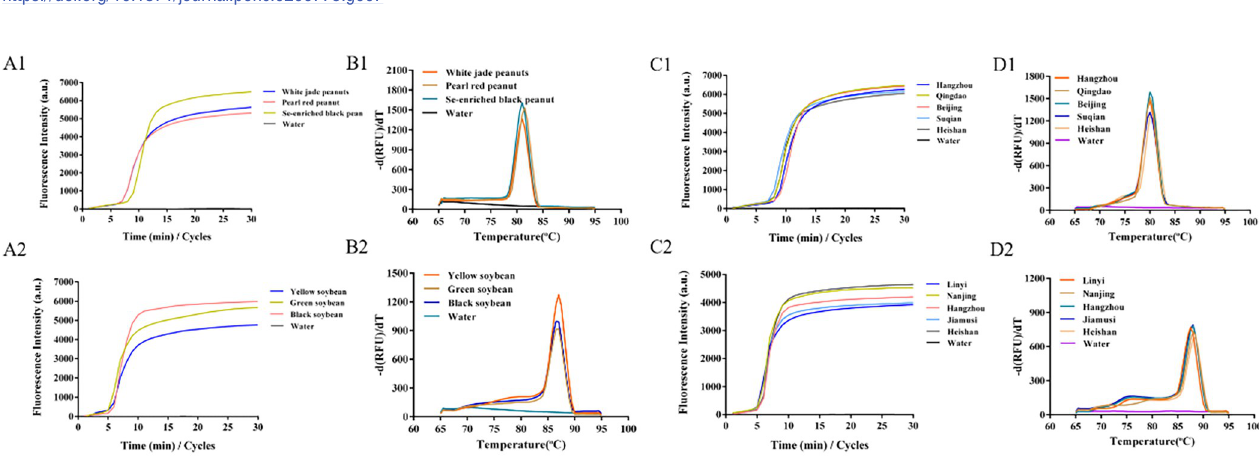
Fig 8. Detection of peanut and soybean allergens in different areas and varieties by LAMP with paper-based microfluidics extraction. Notes: 8A1 & 8C1, amplification curves appeared in peanut samples from different regions and varieties; 8B1 & 8D1, Tm values of peanut from different varieties and different places; 8A2 & 8C2, amplification curves appeared in soybean samples from different regions and varieties; 8B2 & 8D2, Tm values of soybean from different varieties and different places.